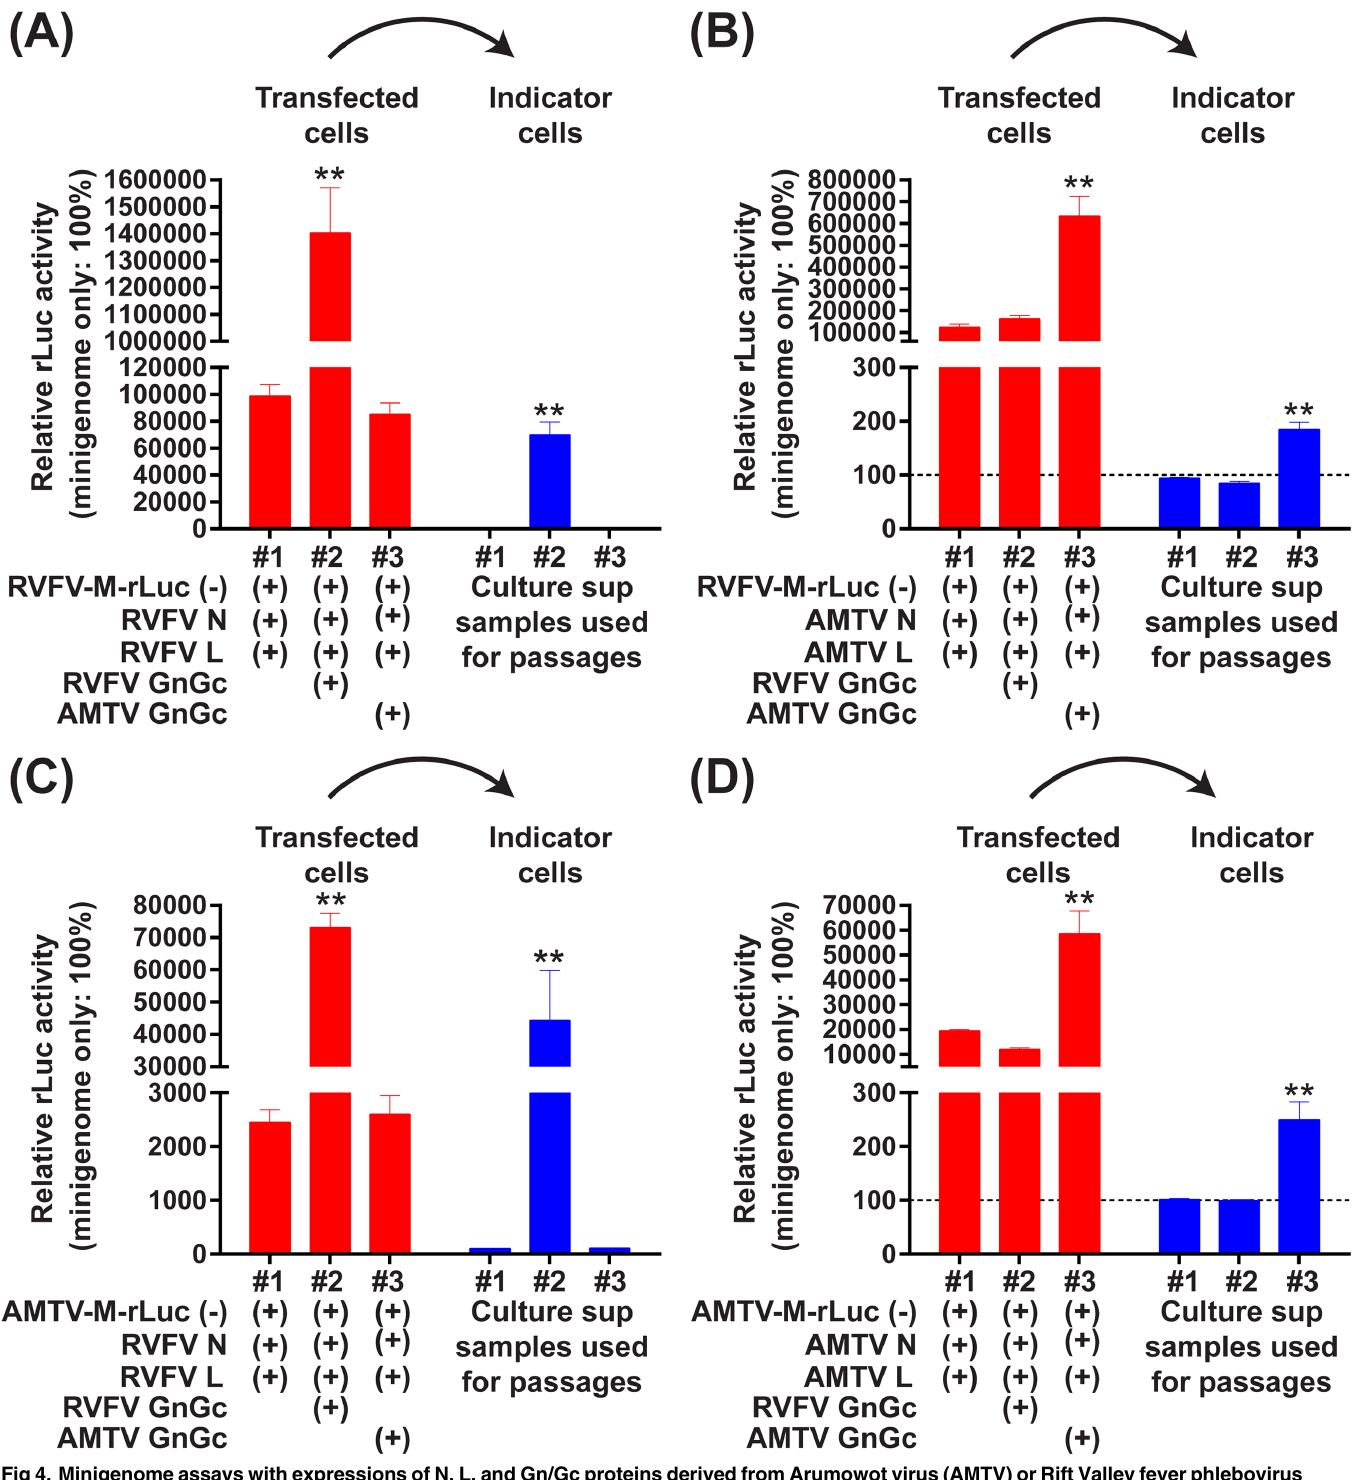
PLOS ONE | https://doi.org/10.1371/journal.pone.0185194 September 19, 2017 12 /